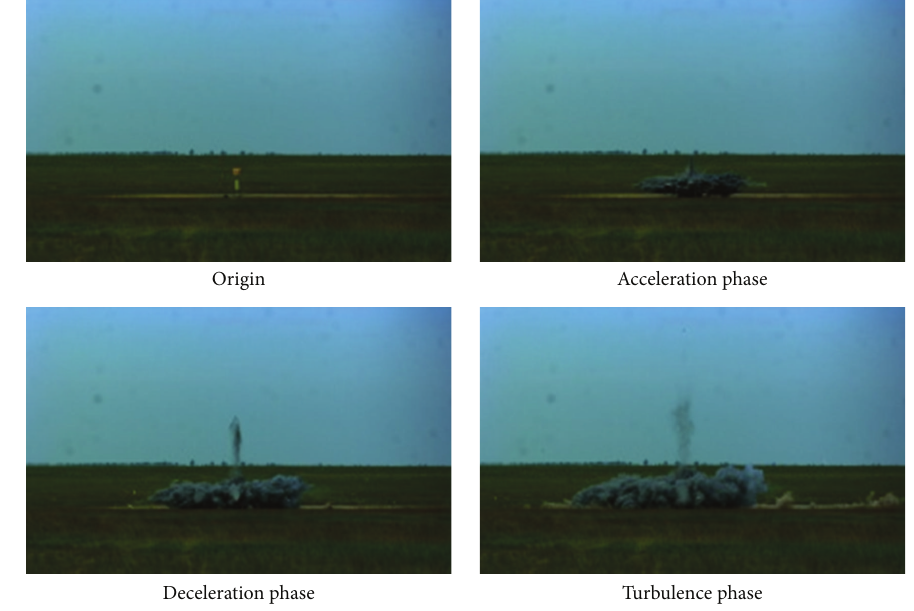
Figure 3: Photos of cylinder clouds taken by a high-speed camera.